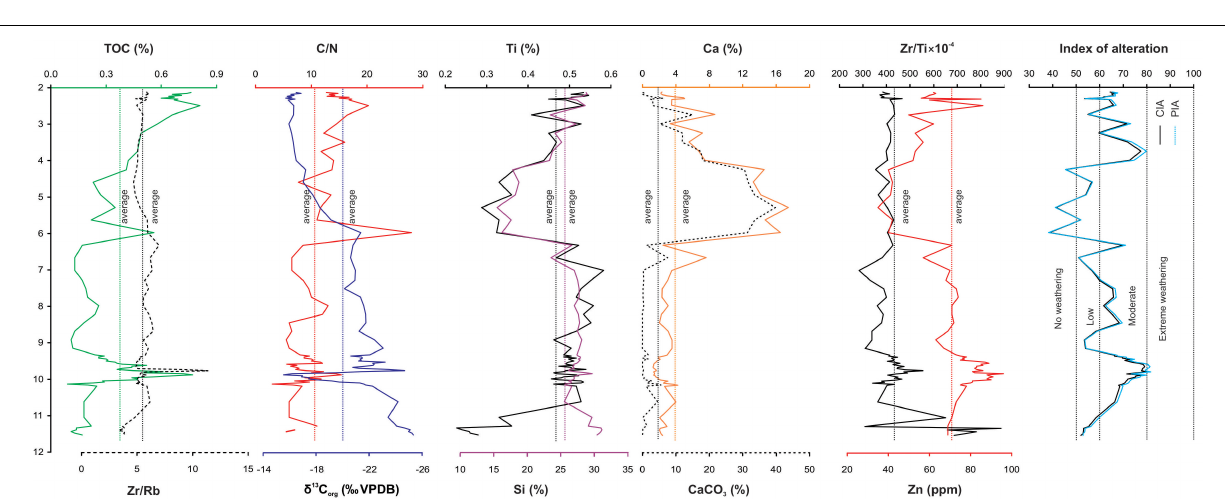
FIGURE 6 | Temporal variations of total organic carbon (TOC), C/N ratio, δ 13 C org , Ti, Si, Ca, CaCO 3 , Zr/Rb ratio, Zr/Ti ratio, Zn, and the indices of alteration estimated through chemical index of alteration (CIA) and plagioclase index of alteration (PIA) of the sediments deposited during ∼ 11.5–2.1 cal ka BP. Dotted lines represent average values of the variables, except for the indices of